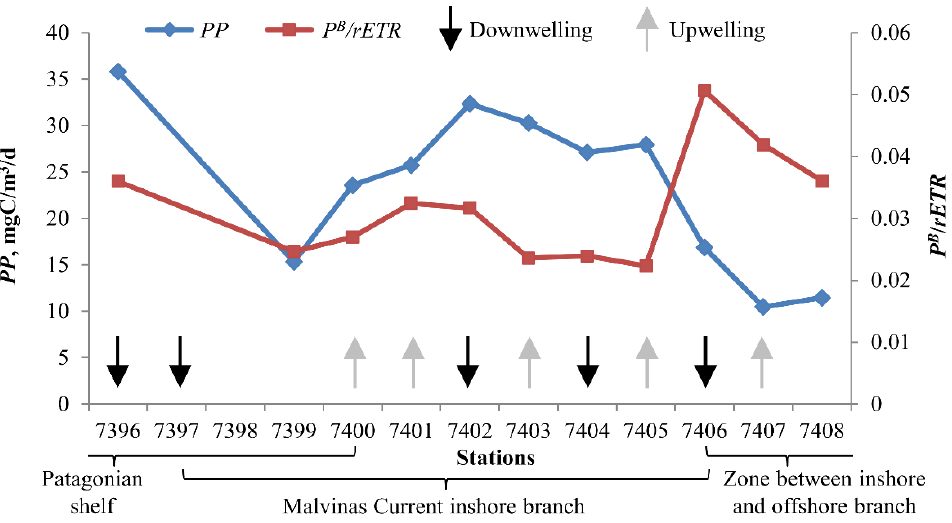
Figure 8. Phytoplankton photosynthetic efficiency ( P B / rETR ) and primary production ( PP ) in the upper 5-m water layer.